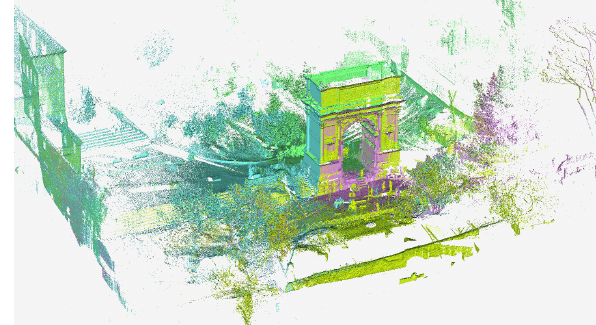
Figure 6: Urban data set with four scans positioned around a Roman arch. Notice the artefacts caused by moving people in front of the arch. For better visibility, only 25% of the points are displayed.